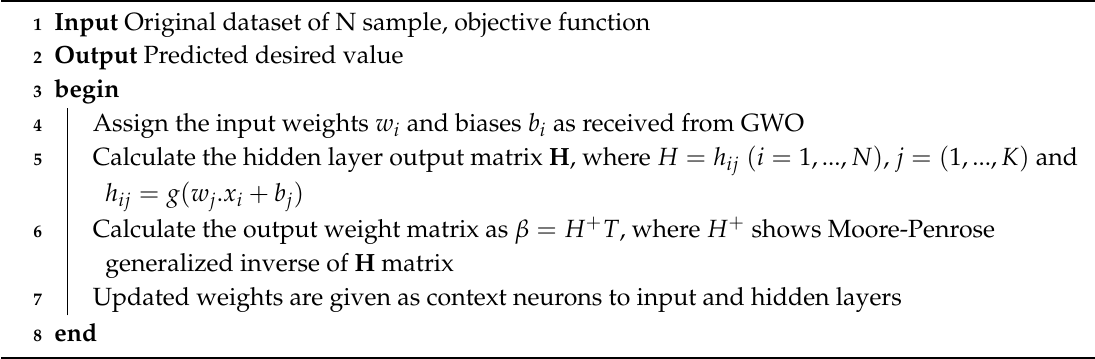
Algorithm 4: Pseudocode of ERELM